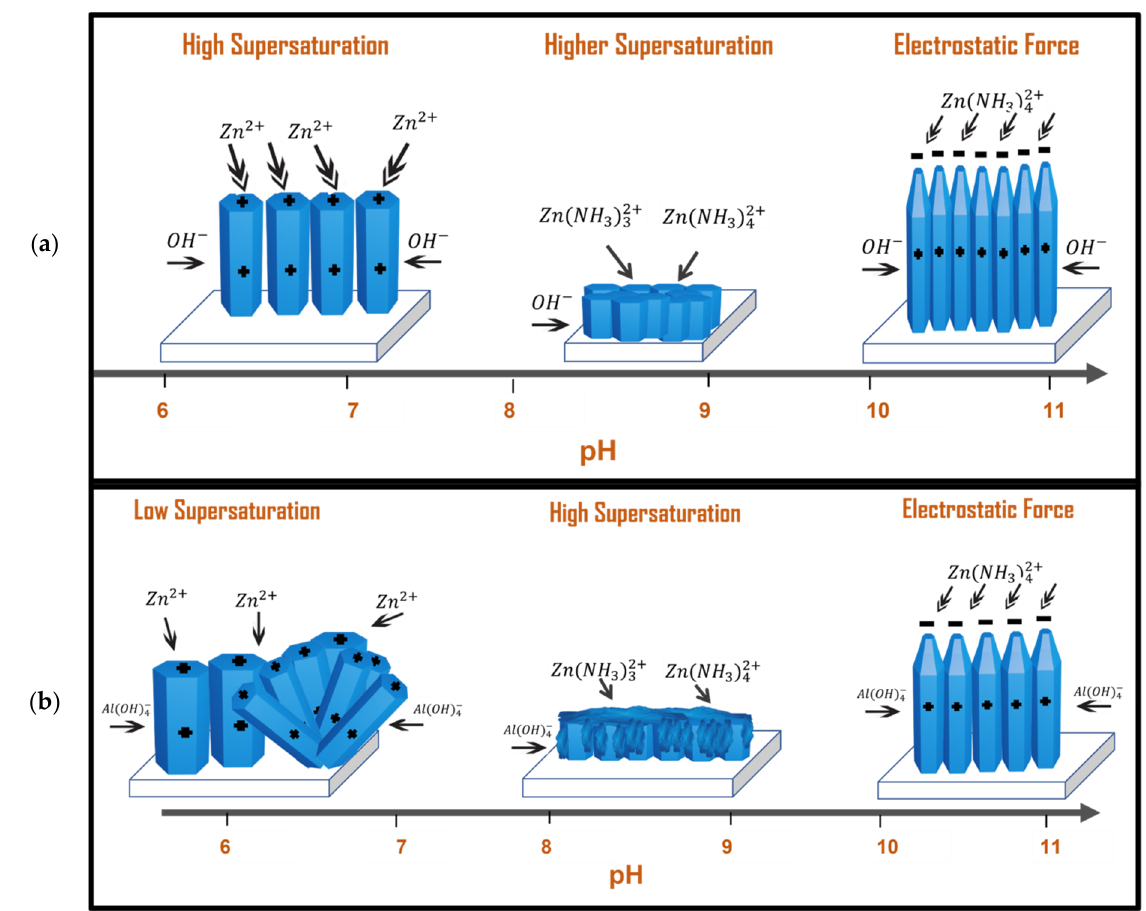
Figure 7. A schematic diagram that represents the growth mechanism of: ( a ) ZnO and ( b ) AZO NRs, in different pH precursors using microwave-assisted hydrothermal method.